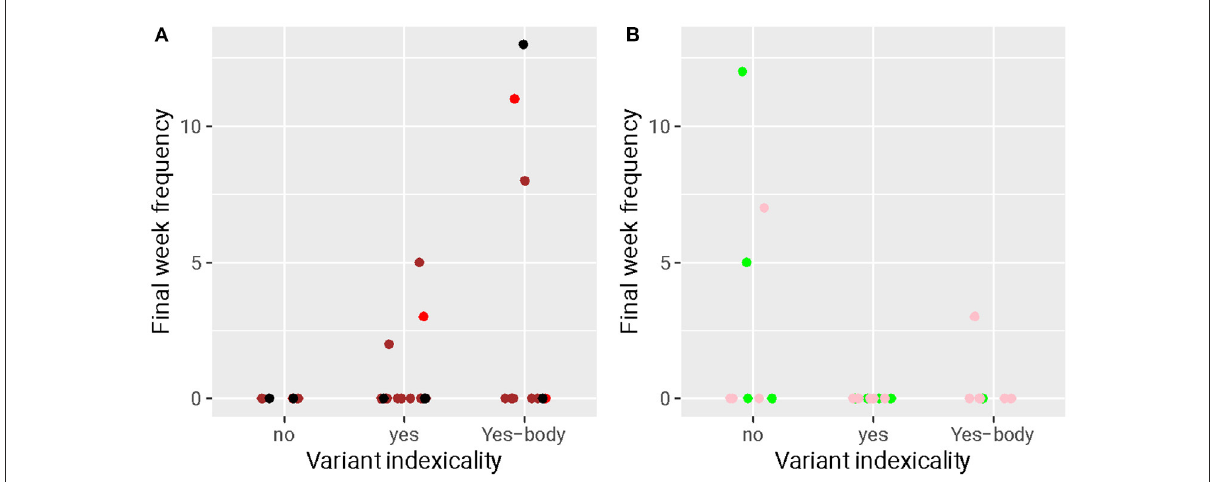
FIGURE8 Frequency in the final week as a function of indexicality of variants, for various colors. The effect of indexicality was stronger for red, brown and black (A) , and weaker for green and pink (B) .